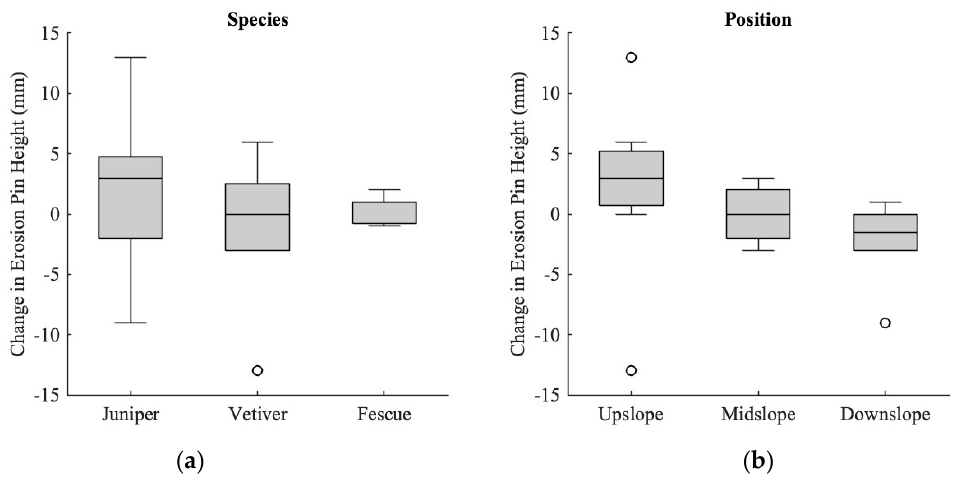
Figure 10. Boxplots showing the change in erosion pin height between 12 October 2021 and 15 April 2022, as grouped by ( a ) species planted on the experimental plot (data from all slope positions included); and ( b ) slope position of the erosion pin (data from all plots included).